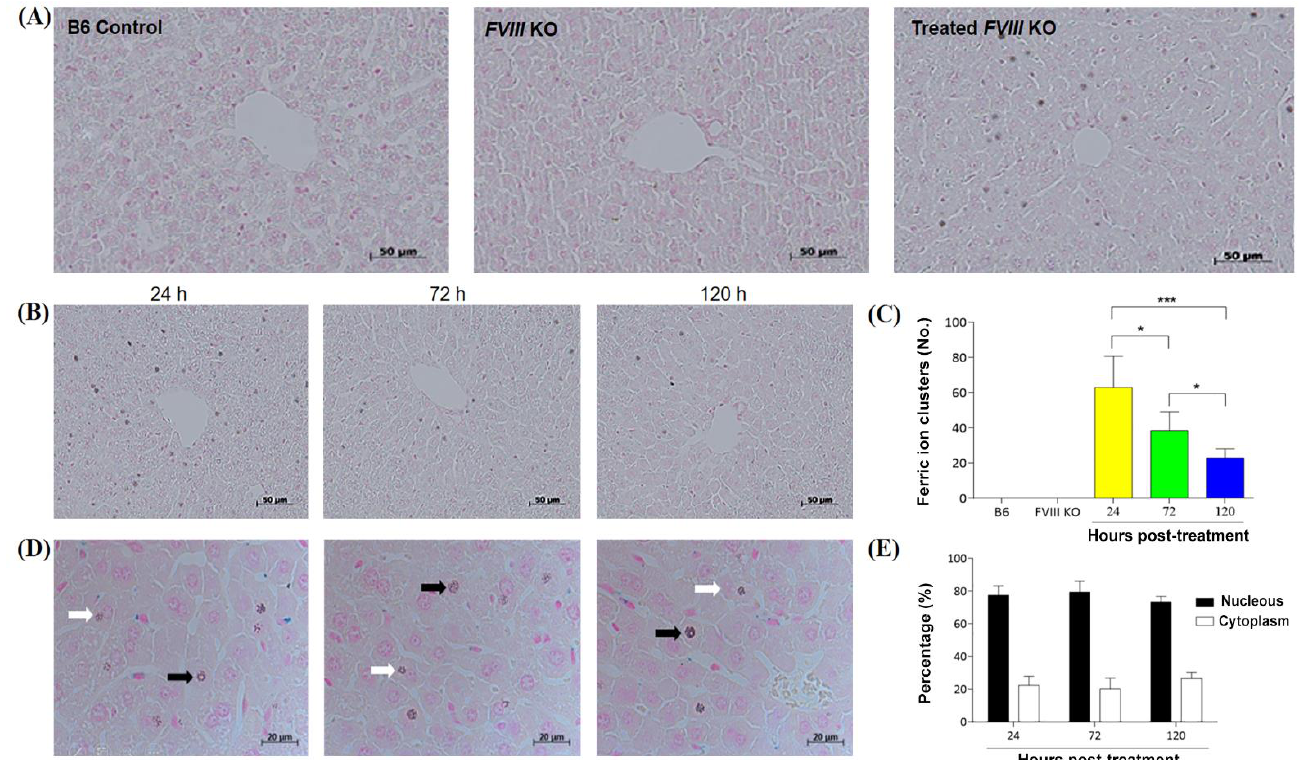
Figure 6. Perls’ Prussian blue staining to observe the localization of DPPC-Fe 3 O 4 -plasmid nanoparticles in the liver sections of recipient mice with hemophilia A. ( A ) Mice were sacrificed at 24 h (n = 3) after delivery of the DPPC-Fe 3 O 4 -plasmid complex, and Perls’ Prussian blue-stained iron oxide was observed in liver sections (right). C57BL/6J mice (n = 6) were used as a normal control (left). Untreated FVIII knockout mice (n = 6) were used as a negative control (middle). Images were obtained at 400 x magnification, scale bar = 50 µm. ( B ) Representative images of the Prussian blue-stained iron clusters at different time points. The recipient mice were sacrificed at 24 h (n = 3), 72 h (n = 3), and 120 h (n = 3) after delivery of the DPPC-Fe 3 O 4 -plasmid complex, and the liver sections were stained with Perls’ Prussian blue. Images were obtained at 400× magnification, scale bar = 50 µm. ( C ) Quantification of iron cluster numbers at different time points. ( D ) Representative images of the iron clusters in the cell nucleus (black arrows) or cytoplasm (white arrows). Images were obtained at 1000× magnification, scale bar = 20 µm. ( E ) Quantification of the percentage of iron clusters in the cell nucleus (black bar) or cytoplasm (white bar) at different time points by counting 100 clusters randomly. Data are presented as the mean ± SD, * p < 0.05, *** p < 0.001 (two-tailed t test).